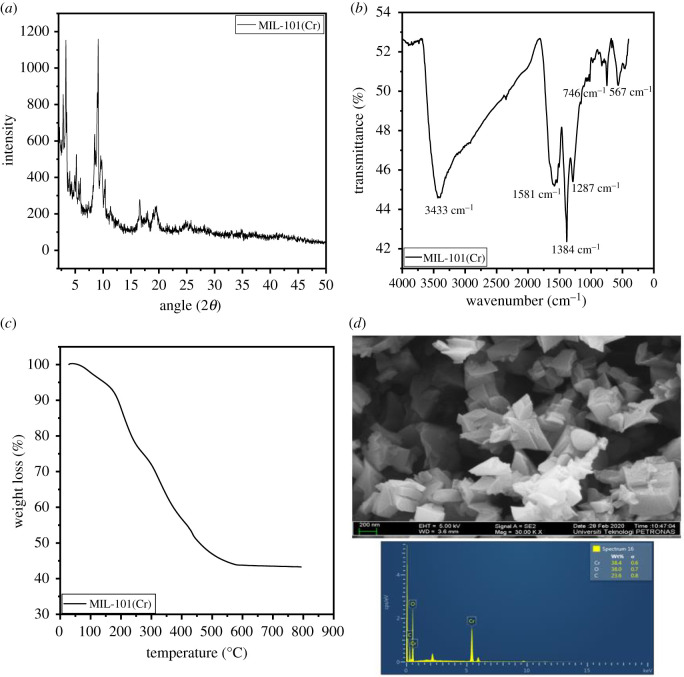
(a) XRD pattern, (b) FTIR spectrum, (c) TGA thermogram and (d) FESEM-EDX spectrum of MIL-101(Cr).